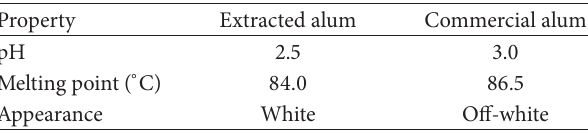
Table 3: Some physical properties of commercial and in-house extracted